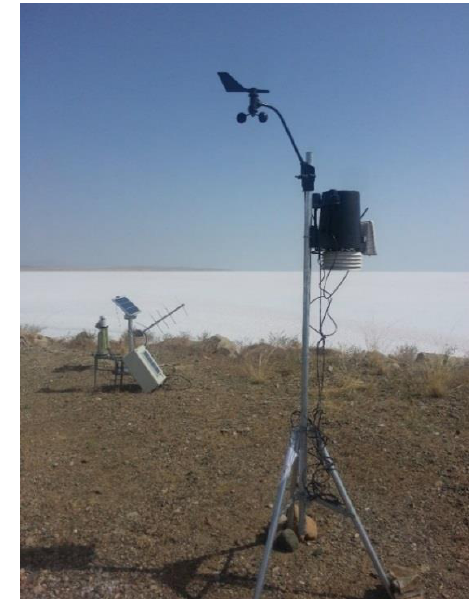
Figure 2. The sun photometer (left) and the meteorology station (right) used at Tuz Gölü September 2015